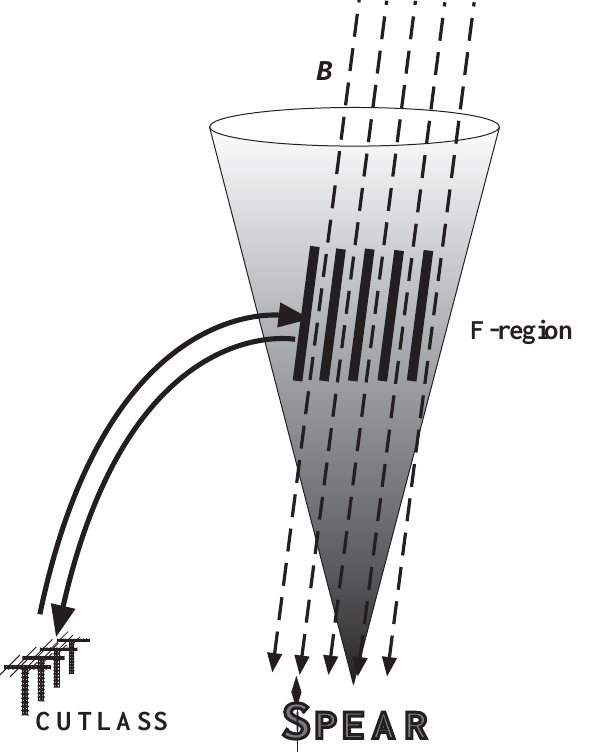
Fig. 2. A schematic representation of field-aligned irregularity gen- eration by a high power heater and a half-hop radio path of an HF radar which receives backscatter from these structures.